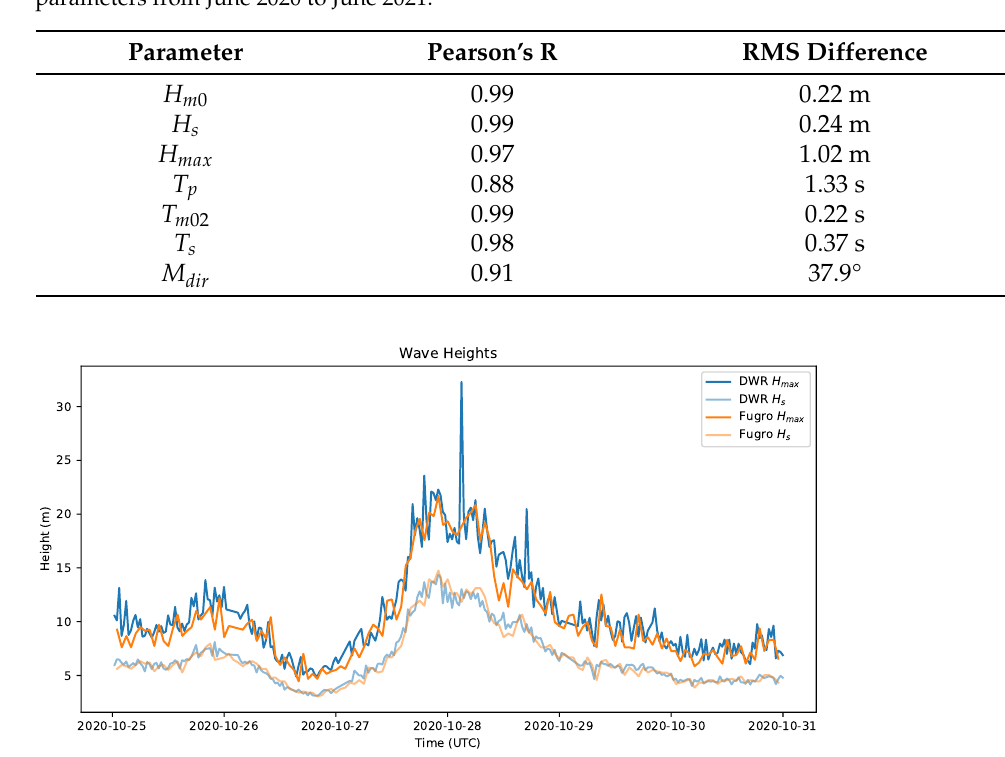
Table 1. Comparison results of Fugro Wavesense and Datawell wave measurement system hourly parameters from June 2020 to June 2021.